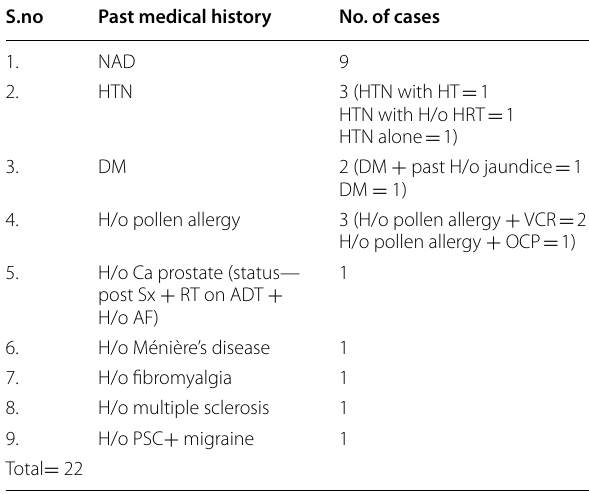
Table 3 Past medical history of persons who succumbed to death